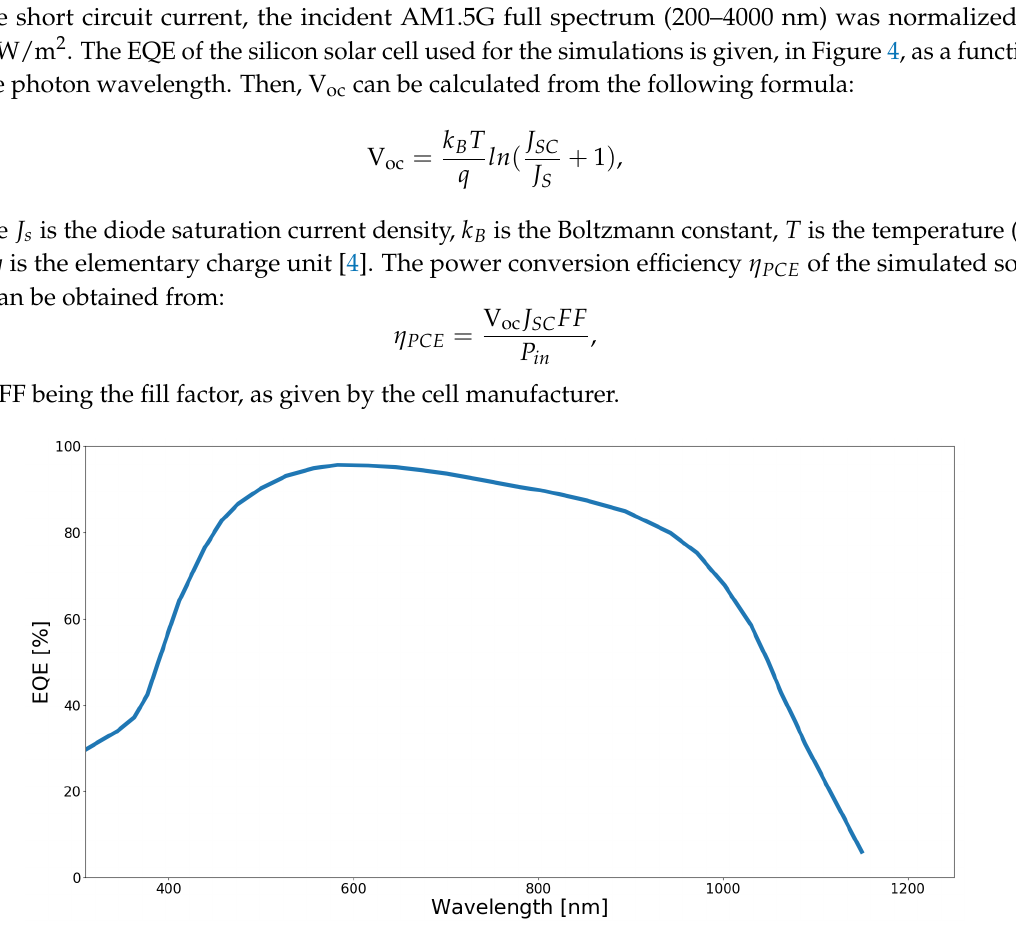
Figure 4. External quantum efficiency (EQE) of the Silicon solar cell